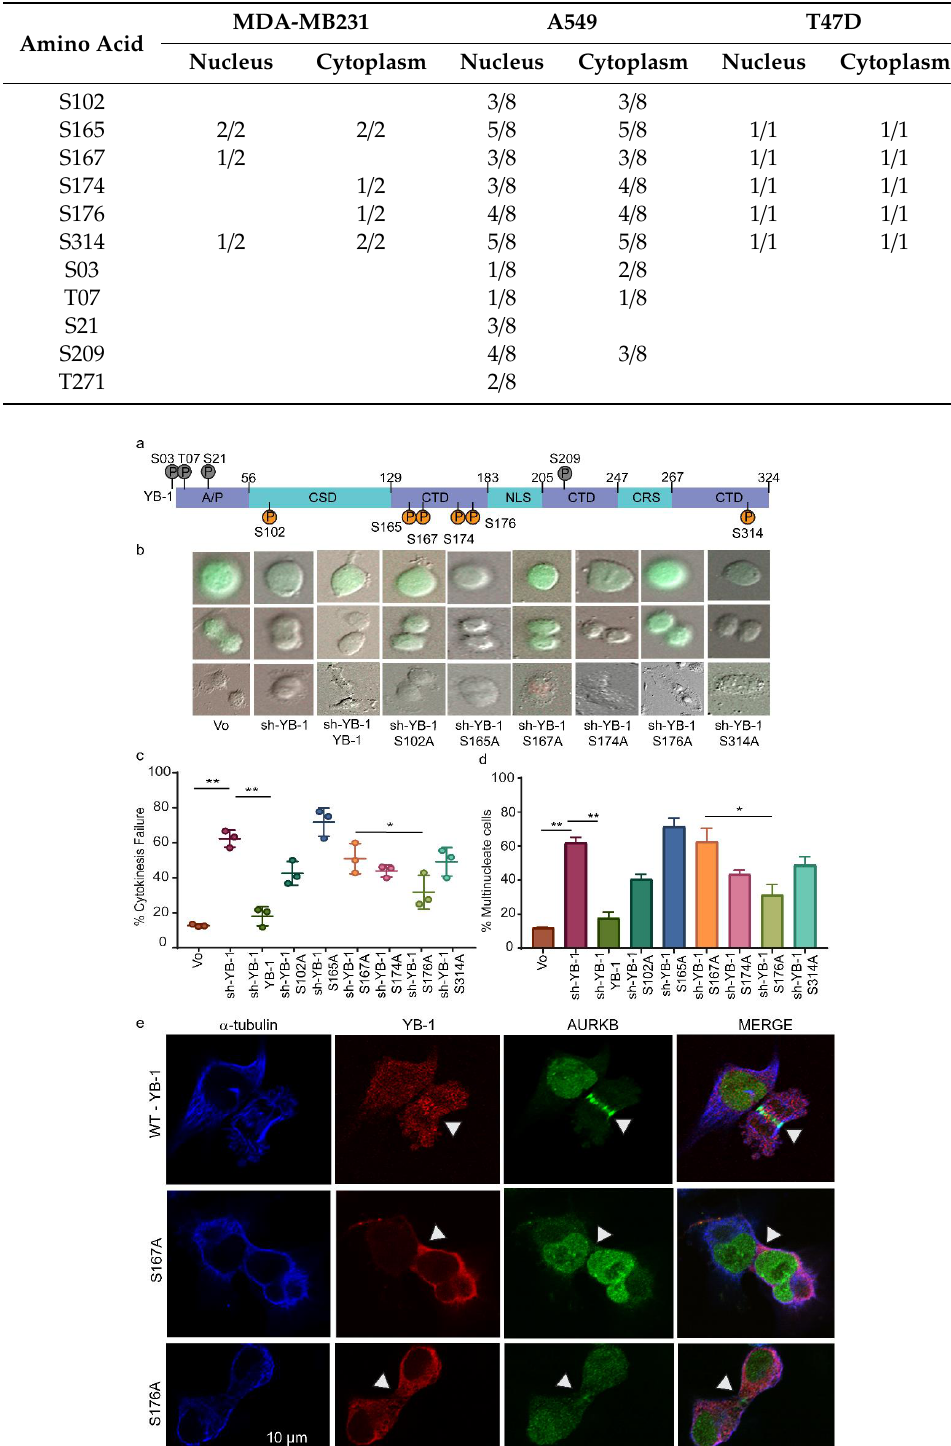
Table 1. Summary of YB-1 phosphorylation sites identified using global LC-MS / MS profiling in A549, MDA-MB-231 and T47D cells. Numerator: number of times phosphorylation site was detected; denominator: total number of LC-MS / MS runs.